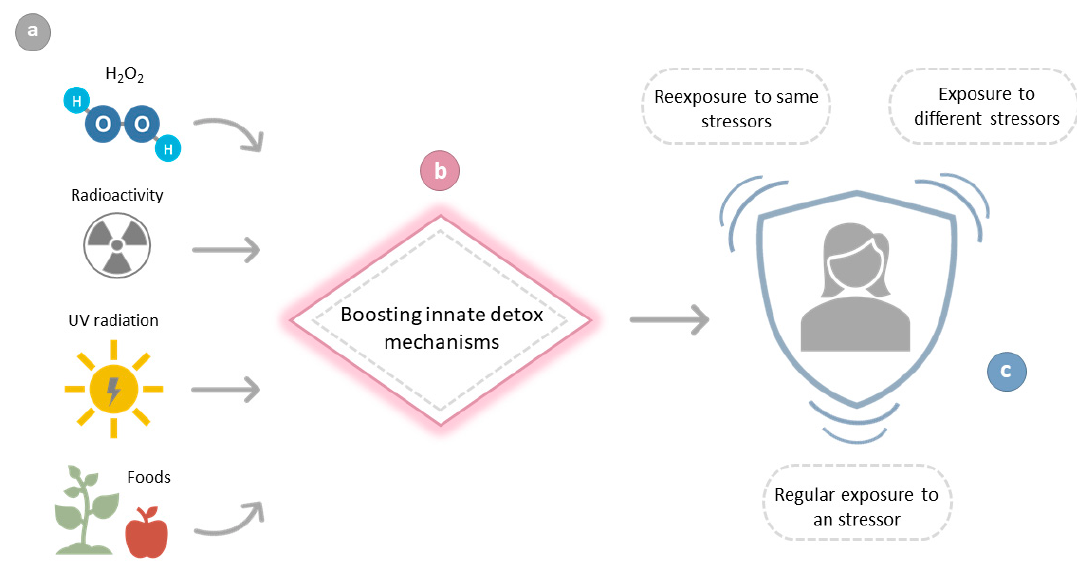
Figure 1. Flow chart illustrating the benefits from a prior exposure to a seemingly noxious agent. Exposure to radioactivity, UV light from the Sun, H 2 O 2 or some foods or chemicals present in foods ( a ) would increase the levels and/or the activities of antioxidant enzymes, thus improving the innate mechanisms of detoxification ( b ) that cope with the oxidative stress generated by a subsequent re-exposure to the same stressor, by exposure to a different stressor or by the regular exposure to a stressor ( c ).